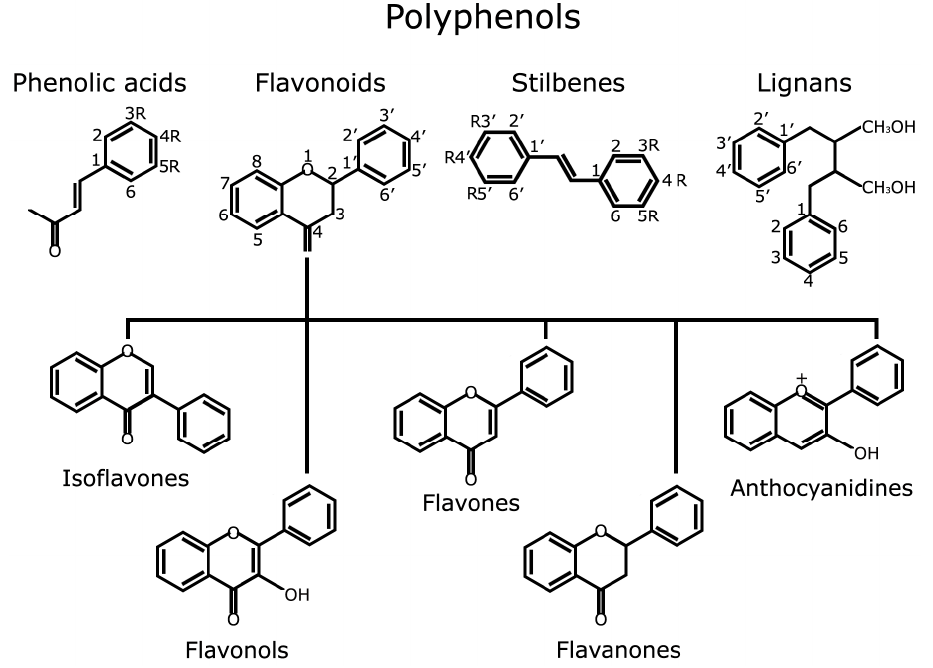
Figure 1. Polyphenols structure and classification.